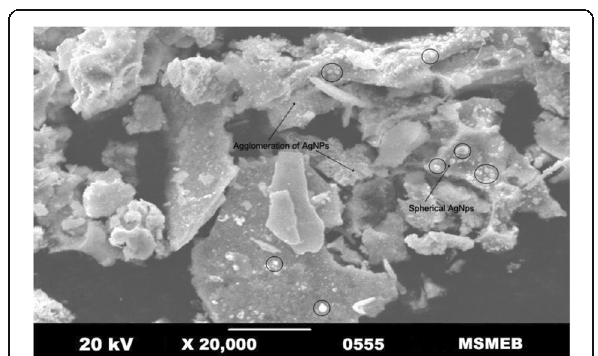
Fig. 5 SEM analysis of R. laetus -mediated